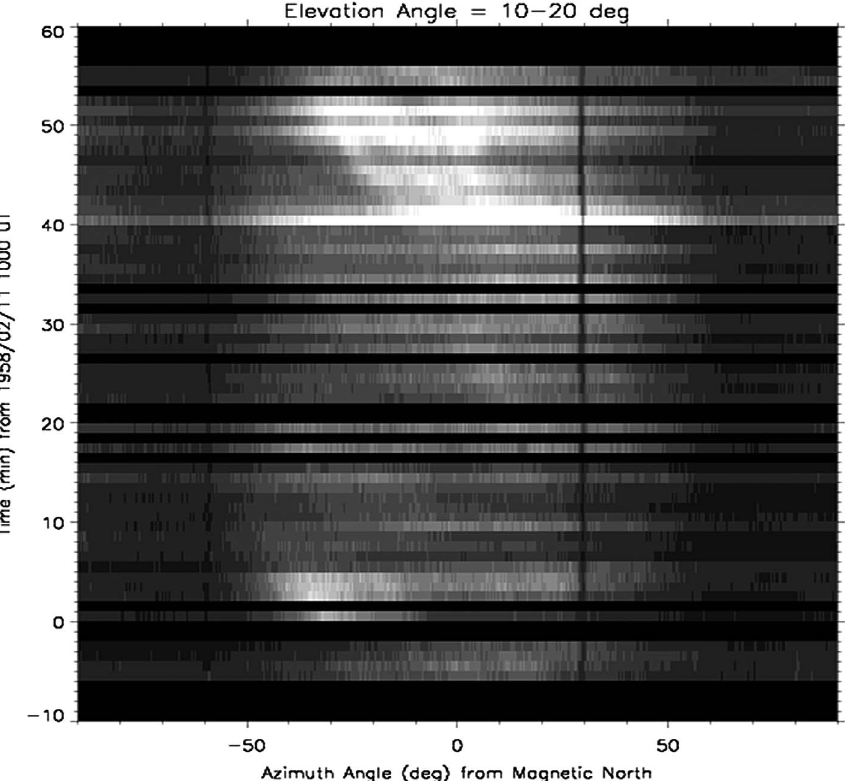
Fig. 5. Time – position diagram of panchromatic auroral intensity at 0950 – 1100 UT at 10 – 20 (cid:1) elevation angle. Time is to the top, and the horizontal axis is the azimuth angle from the magnetic